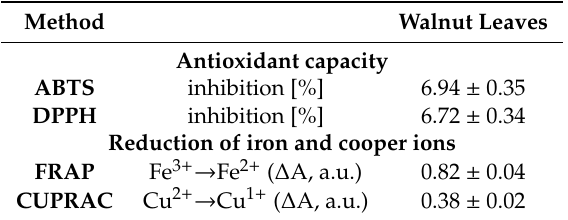
Table 4. Antioxidant capacity and ability to reduce iron and cooper ions of extracts of walnut leaves.